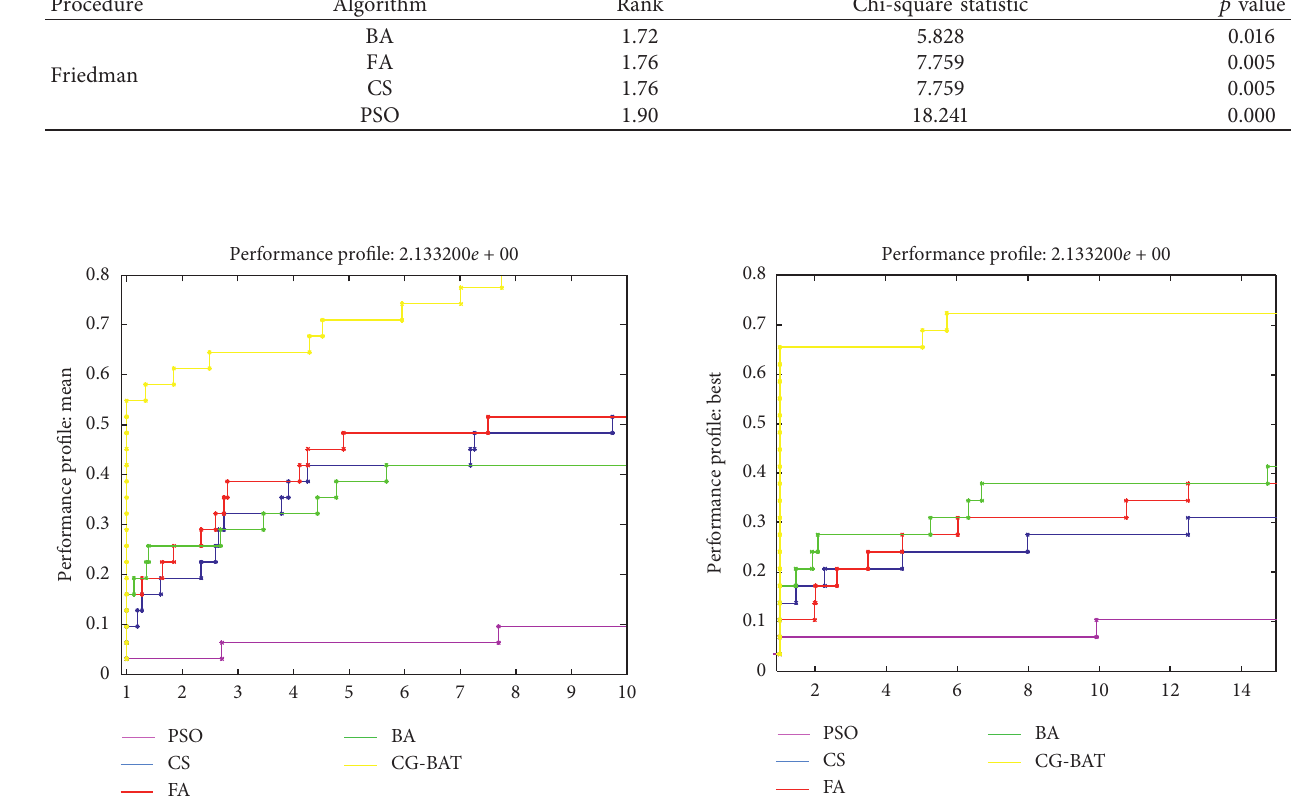
Figure 5: Performance profiles based on mean.